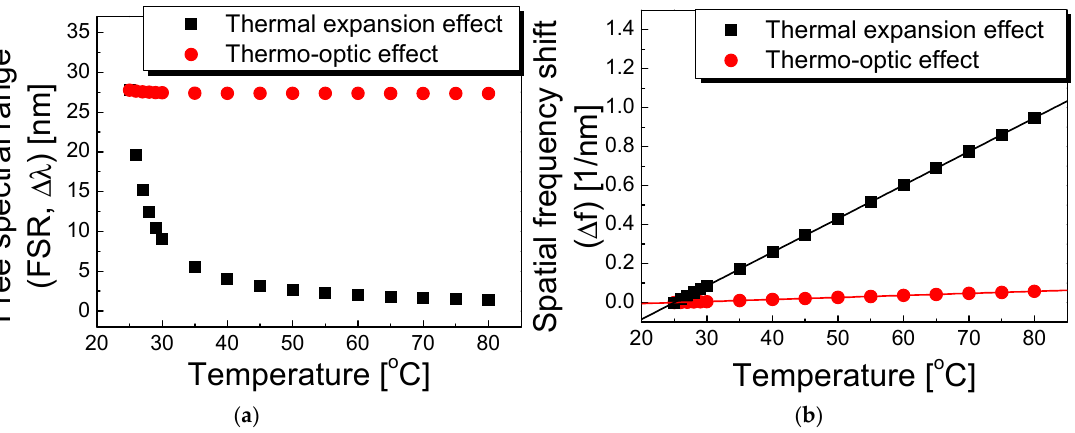
Figure 3. Theoretical results on the FSR variation ( a ) and the spatial frequency shift ( Δ f ) ( b ) as functions of the temperature by considering the thermal expansion and the thermo-optic effects.